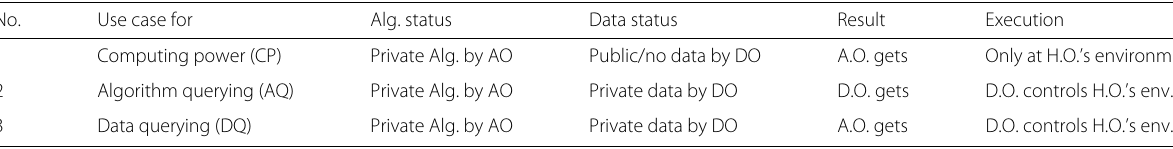
Table 5 Three use cases on secret-code execution through SGX enclaves